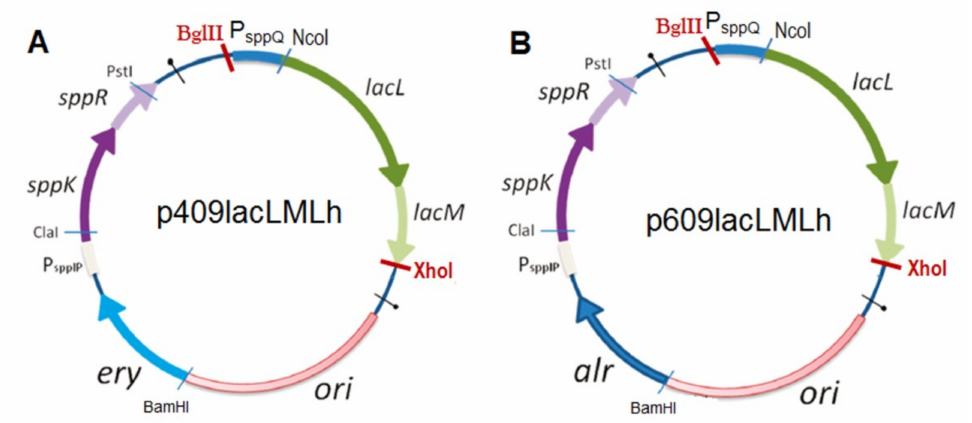
Figure 6. Expression vectors for lacLM from L. helveticus DSM 20075 in L. plantarum based on the erythromycin resistance gene ( erm ) [31] ( A ) and the alanine racemase gene ( alr ) [32] ( B ) as selection markers. sppK and sppR , denoting a histidine kinase and a response regulator, respectively, are regulated by P sppIP . Overlapping genes lacLM from L. helveticus are controlled by the inducible promoter PsppQ (pSIP409